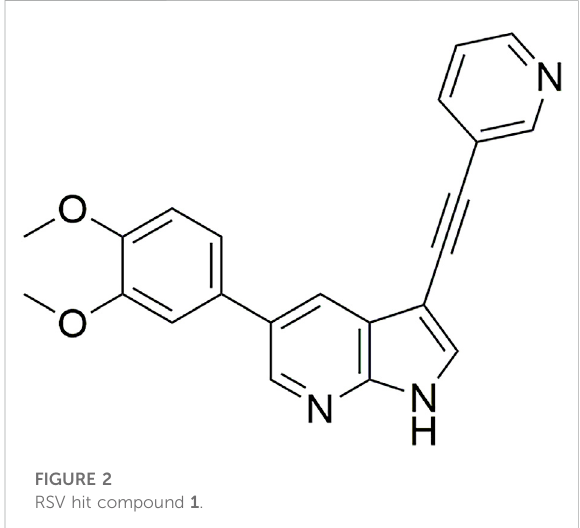
FIGURE 2 RSV hit compound 1